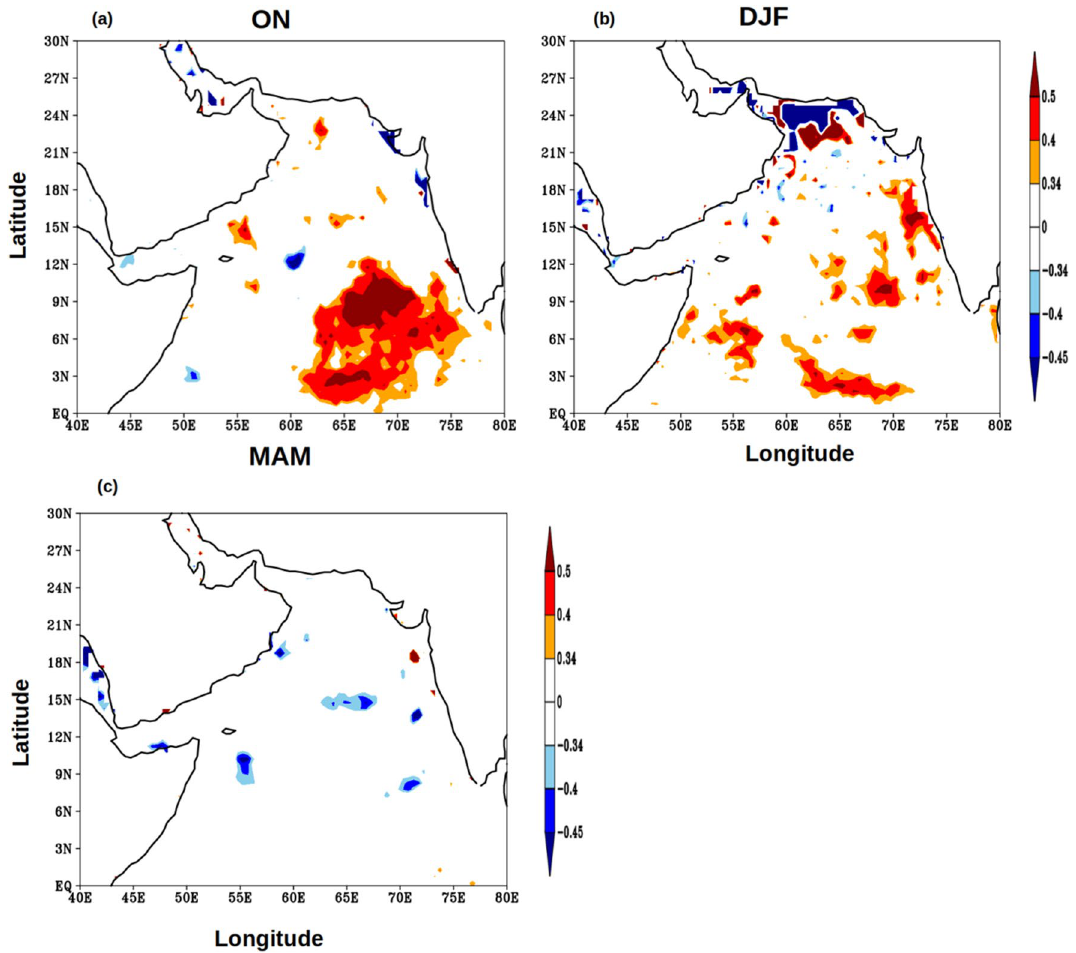
Figure 10. Monthly lead anomaly correlation of West Indian coastal rainfall (WICR) with UOHC in the Arabian Sea during ( a ) ON, ( b ) DJF, and ( c ) MAM for the period of 1980–2015. The red and blue colours represent the significant positive and negative correlation value respectively at 95%